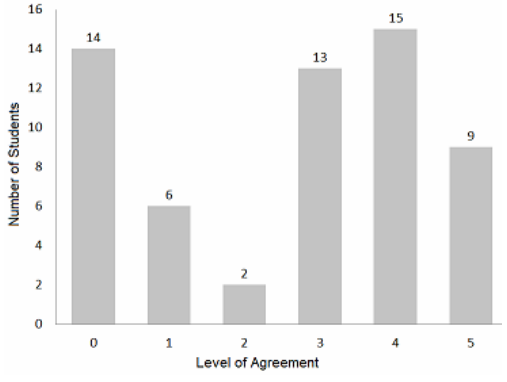
Figure 3. "Discussion forums were useful and relevant"